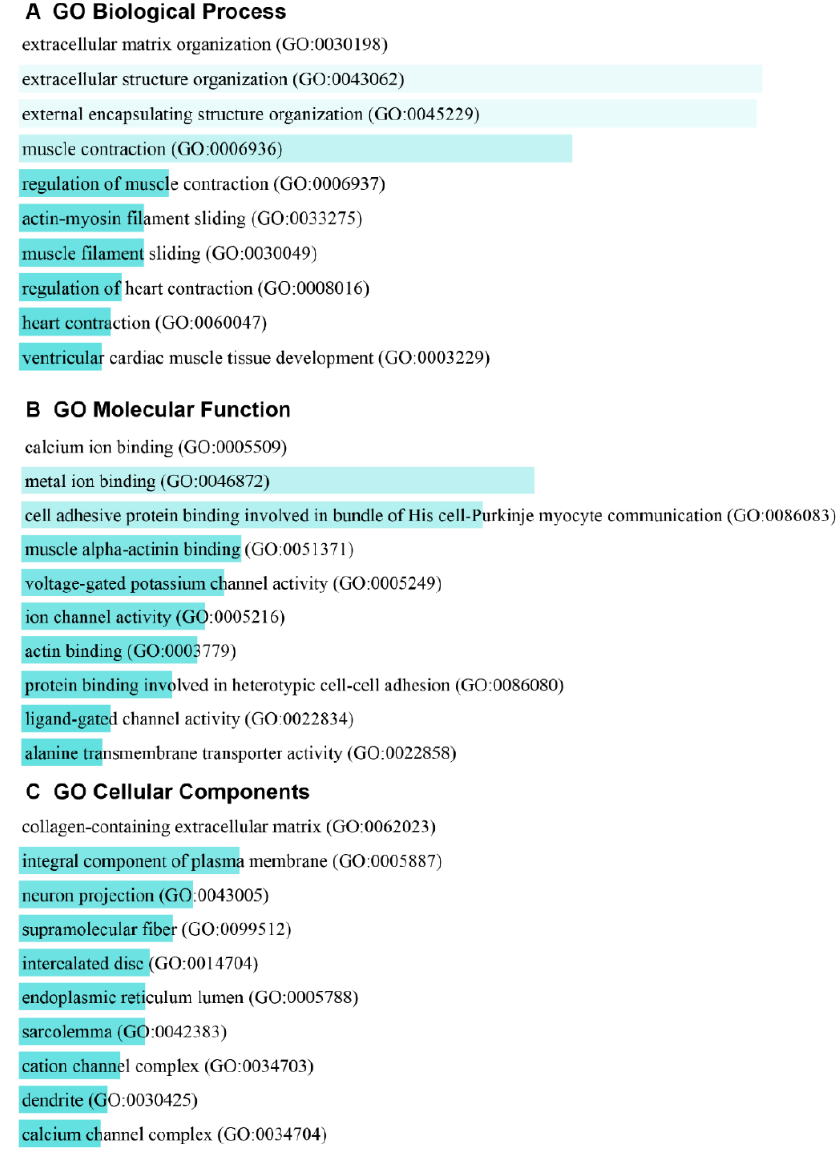
Figure 2. GO analysis of differentially expressed genes in ovaries between TGFBR1-CA and control mice. ( A – C ) Top 10 GO biological processes, molecular functions, and cellular components revealed by Enrichr analysis using DE genes from RNA-seq. Full lists are shown in Supplementary Tables